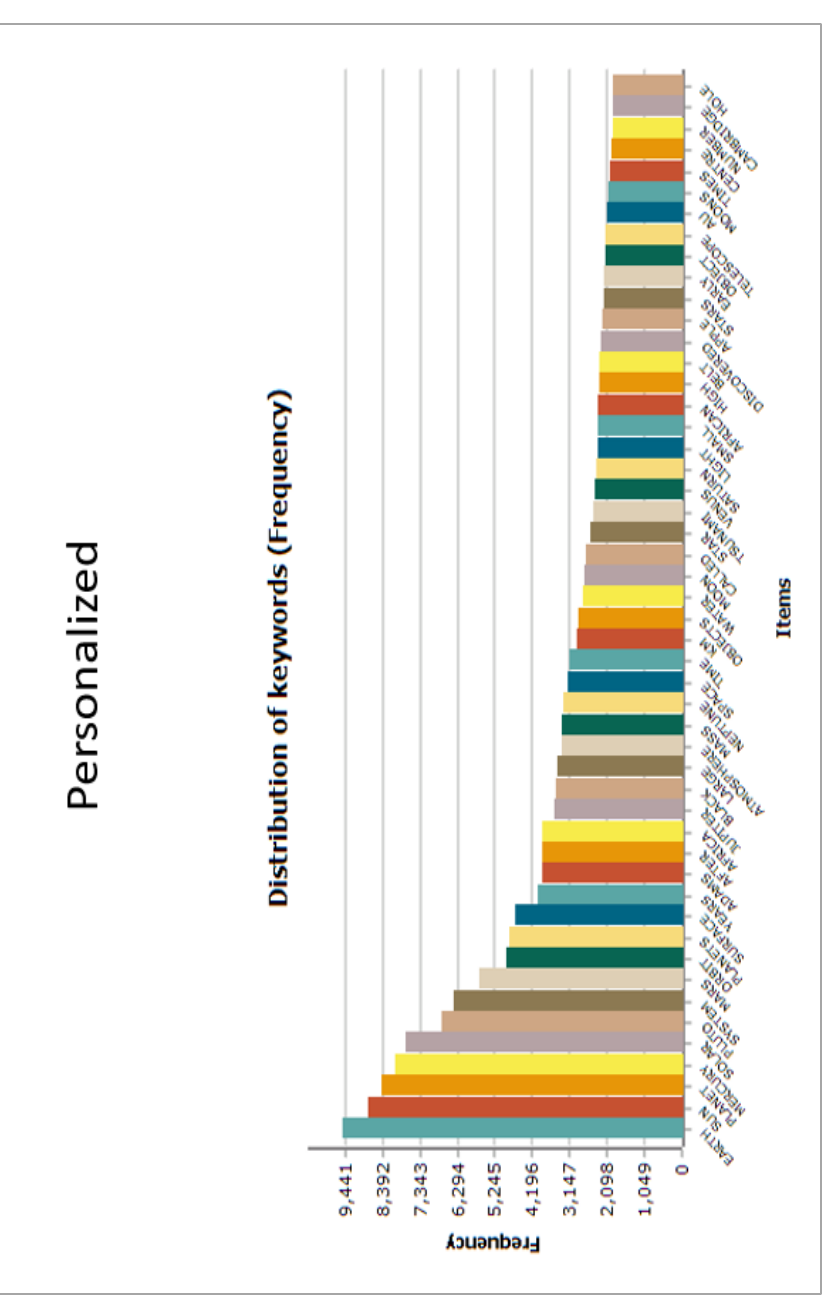
Fig. 7. Distribution of keywords for personalized support